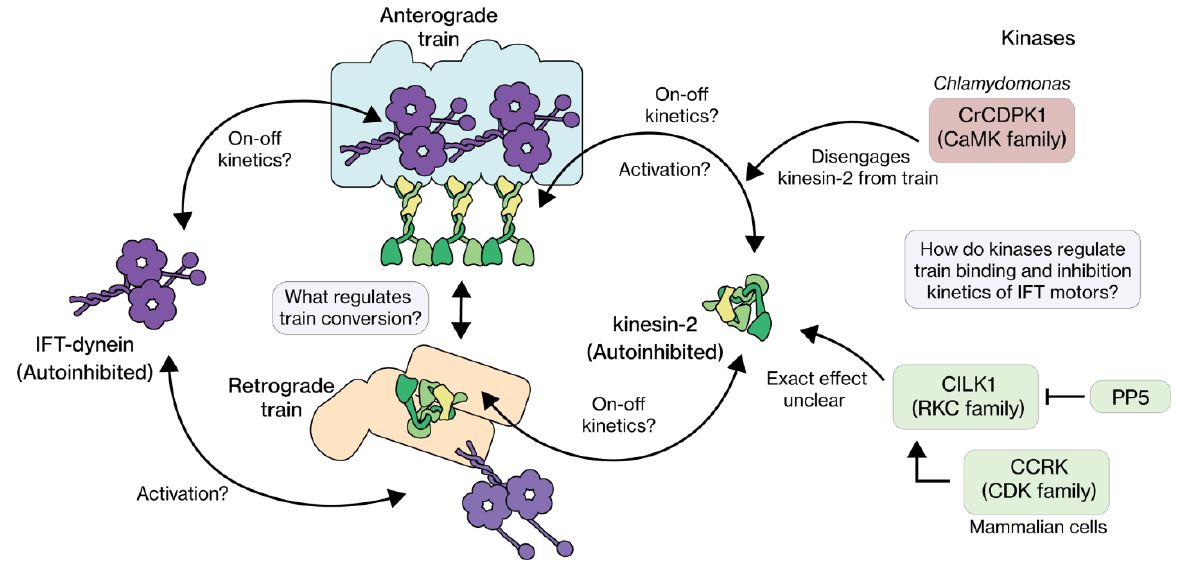
Figure 5. The IFT train binding and autoinhibition kinetics of IFT motors. Kinesin-2 motors are active when coupled to anterograde trains, but switch to an autoinhibited state upon unbinding, linking as passive cargo on retrograde trains or moving diffusively. IFT dynein engages with anterograde trains in an autoinhibited state and become active upon binding to retrograde trains, at the ciliary tip. Kinases and other regulators are likely involved in regulating the train (un)binding and autoinhibition kinetics, but the picture is still quite unclear, especially for IFT dynein.